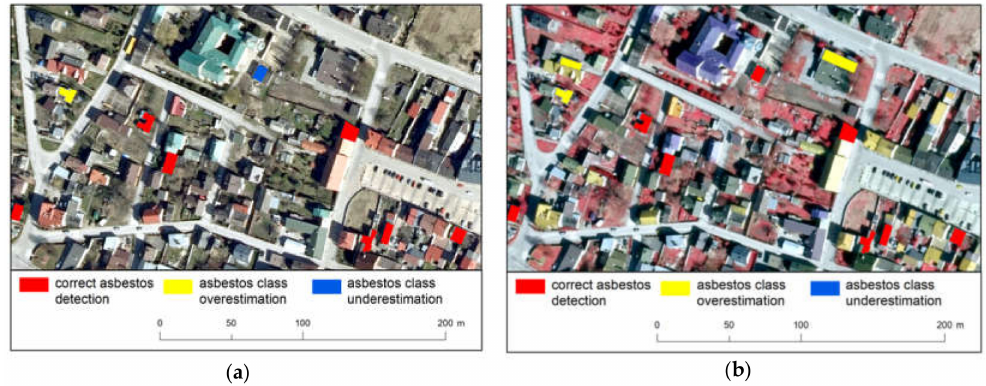
Ch˛eciny: ( a ) RGB composition; ( b ) CIR composition.